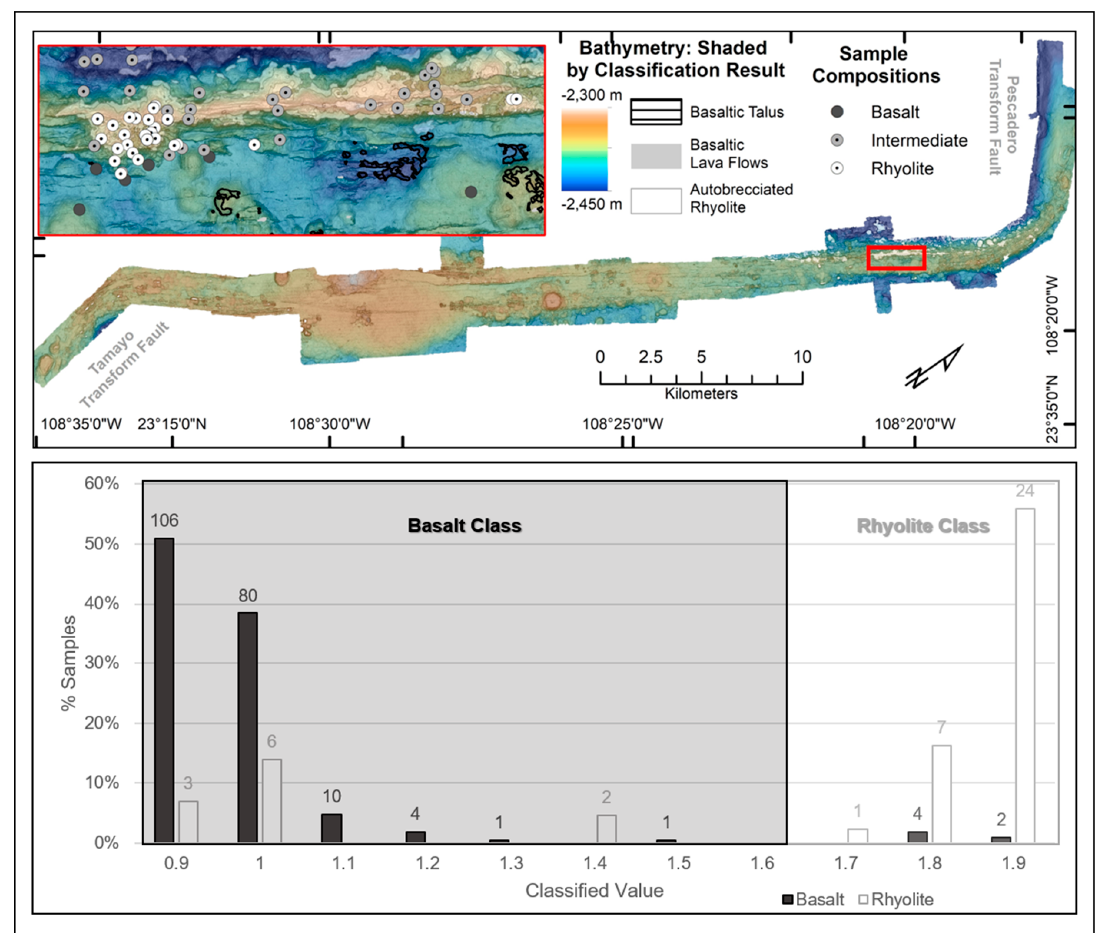
15 of 21 Table 3. Normalized percent of pixels assigned by classification for known sample lava composition.